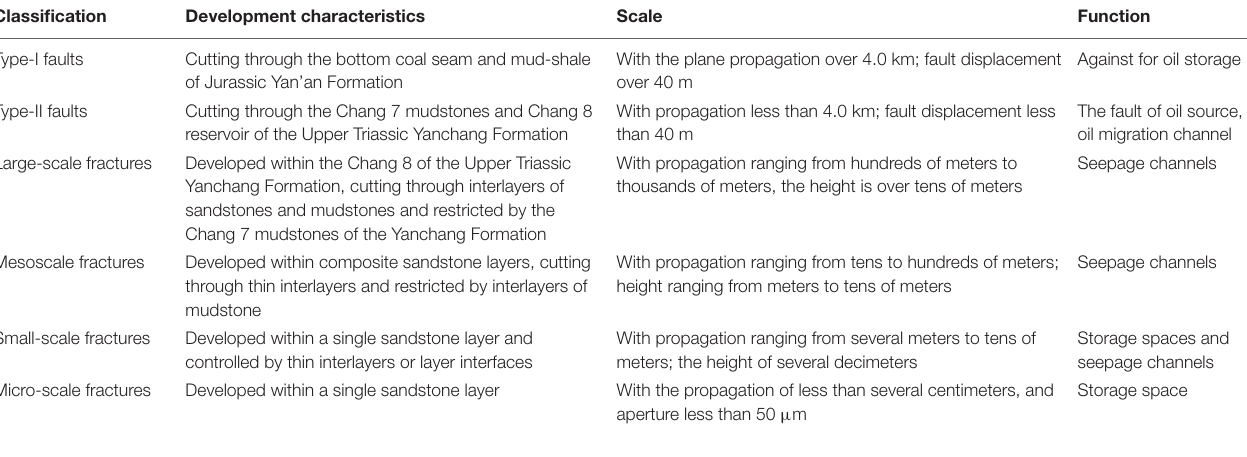
TABLE 1 | Multi-scale fault and fracture classification and their characteristics.